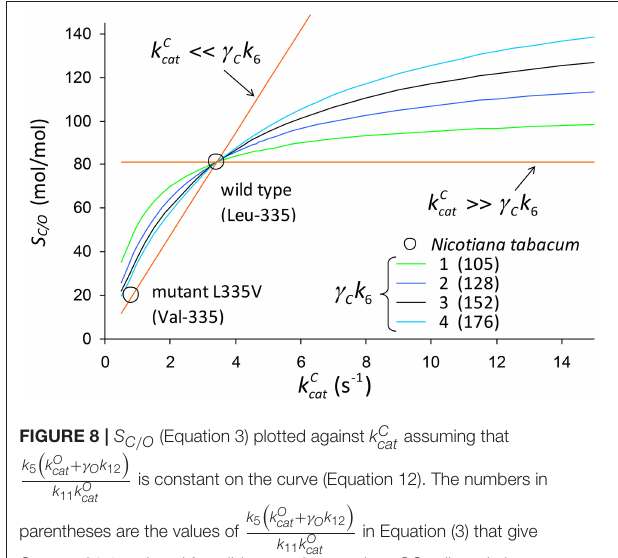
FIGURE 8 | S C / O (Equation 3) plotted against k C cat assuming that k 5 k O cat + γ O k 12 is constant on the curve (Equation 12). The numbers in (cid:17) (cid:16) k 11 k O cat k O cat + γ O k 12 k 5 parentheses are the values of in Equation (3) that give (cid:16) (cid:17) k 11 k O cat S C / O = 81.1 mol / mol for wild-type tobacco given CO 2 dissociation